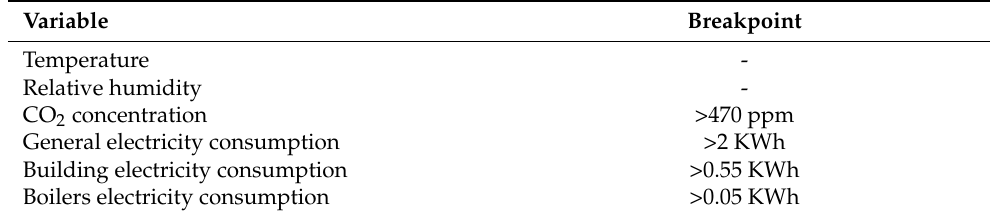
Table 3. Occupancy status